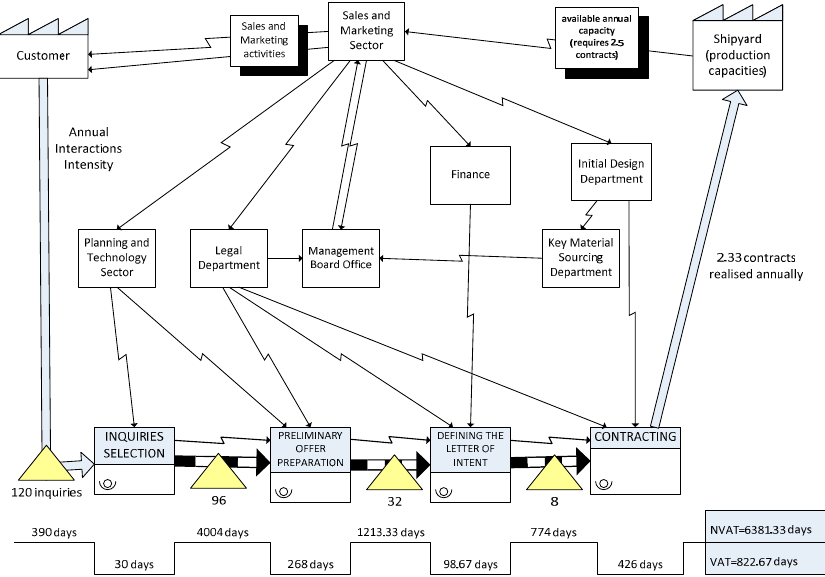
Figure 3. Current state Value Stream Map.